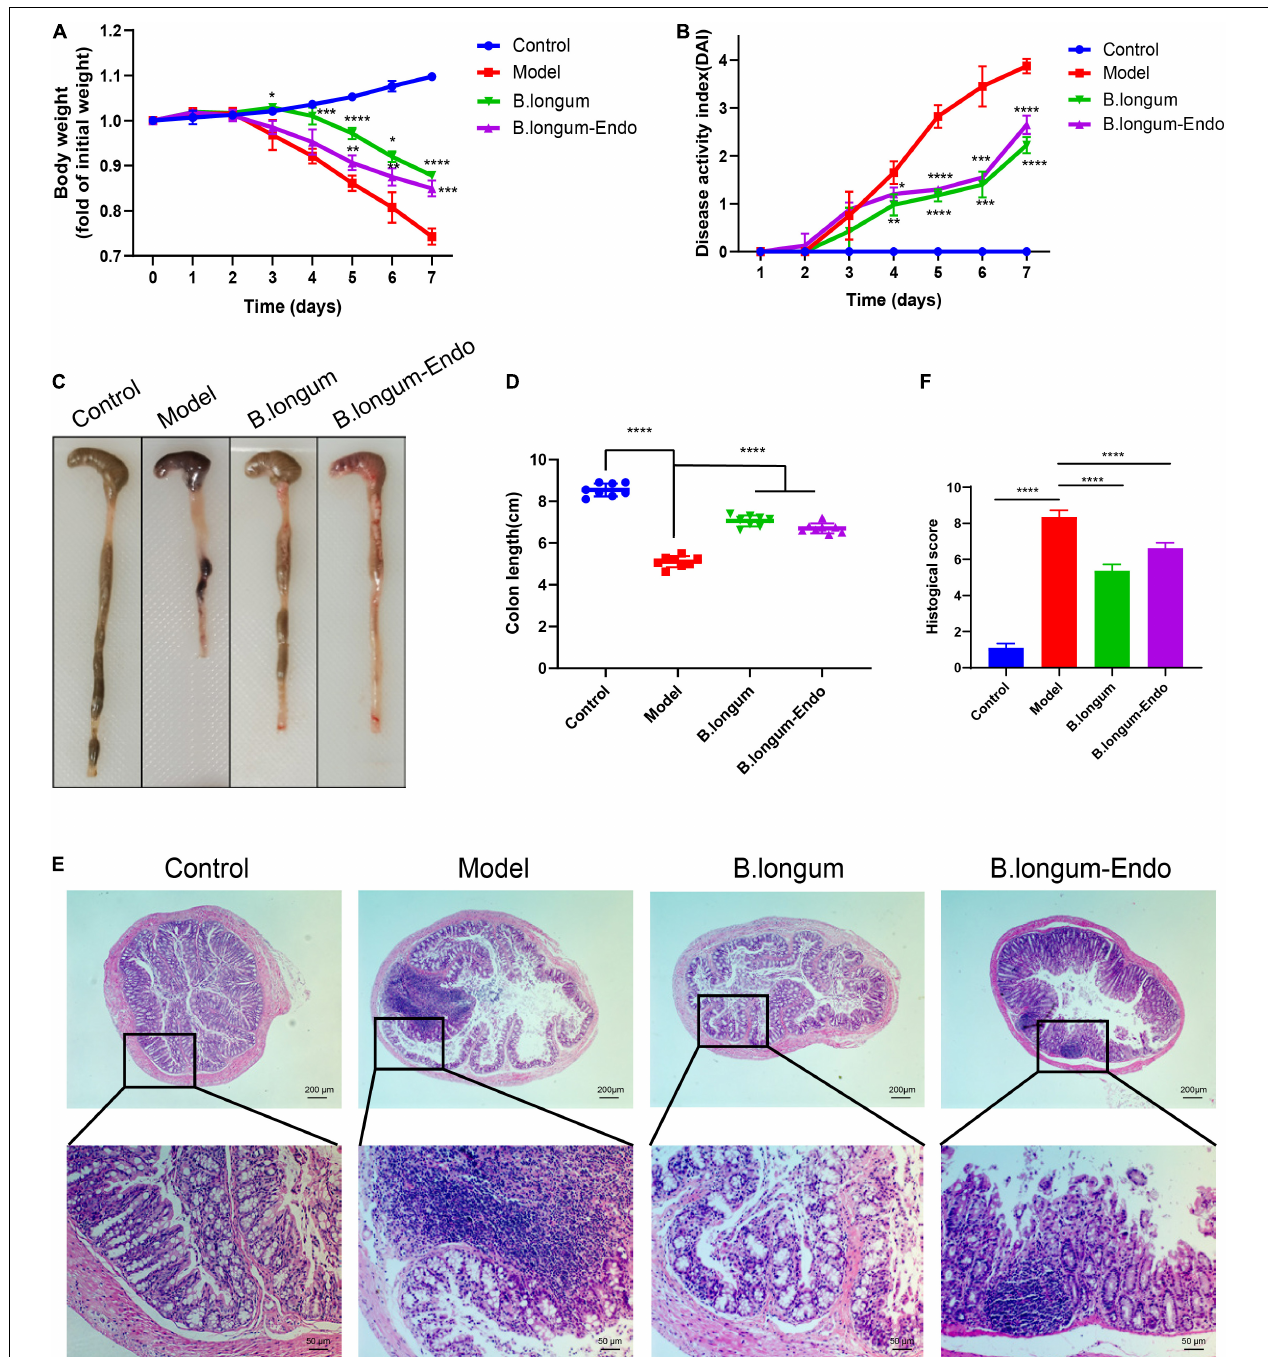
FIGURE 2 | B. longum alleviates DSS-induced acute inflammatory bowel disease in mice. (A) Percentage change in body weight. (B) Disease activity index score, a composite measure of weight loss, stool consistency, and blood in stool. (C) Representative photographs showing colon tissue. (D) Changes in colon length. (E) Representative hematoxylin and eosin-stained sections of colon. (F) Histopathological scores. Data are represented as mean ± SD of three independent experiments ( n = 8). * P < 0.05, ** P < 0.01, *** P < 0.001, **** P < 0.0001, and ns: not significant.